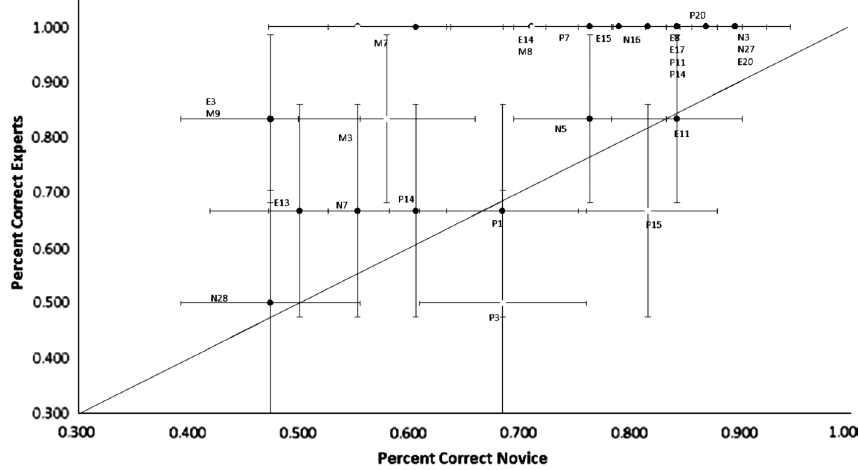
FIG. 4. Percent correct for novices and experts (TAs).